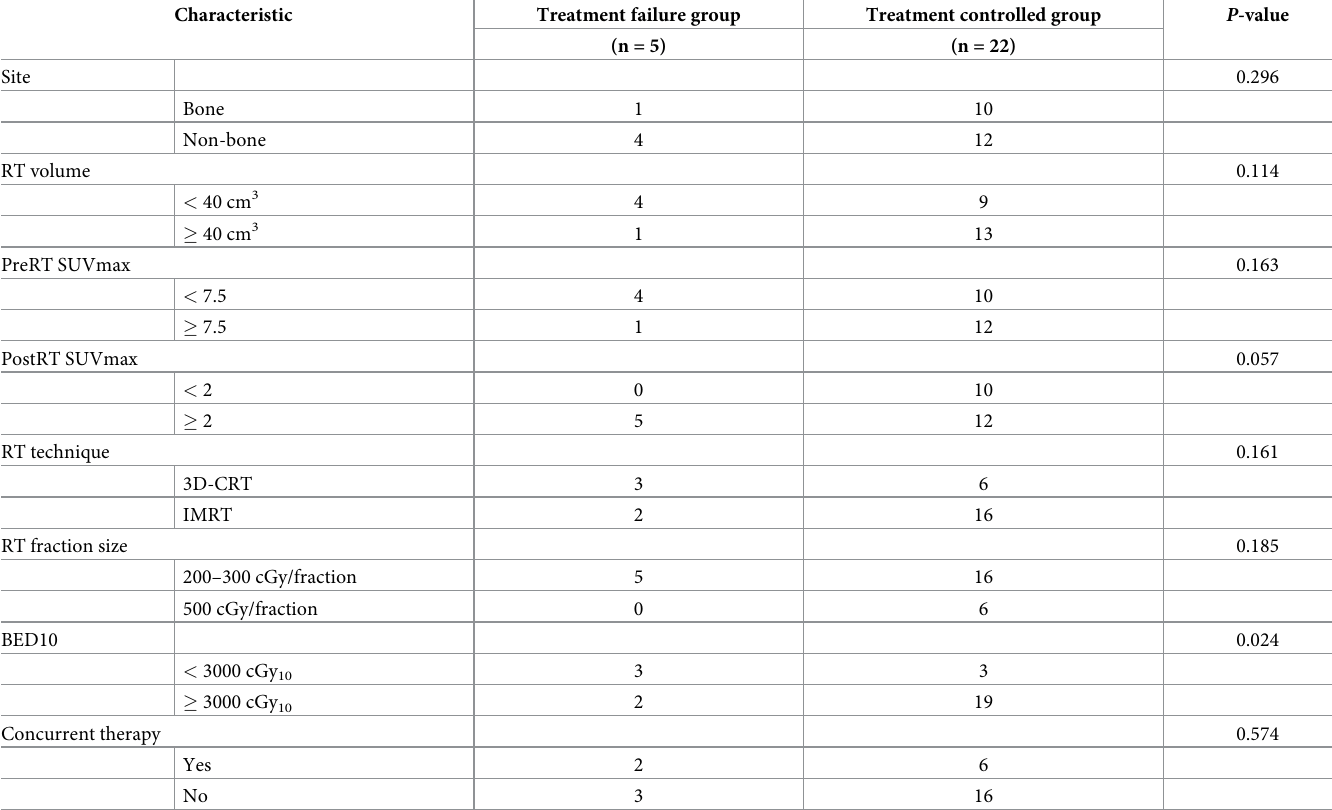
Table 5. Comparison of clinical factors between treatment failure and controlled groups.